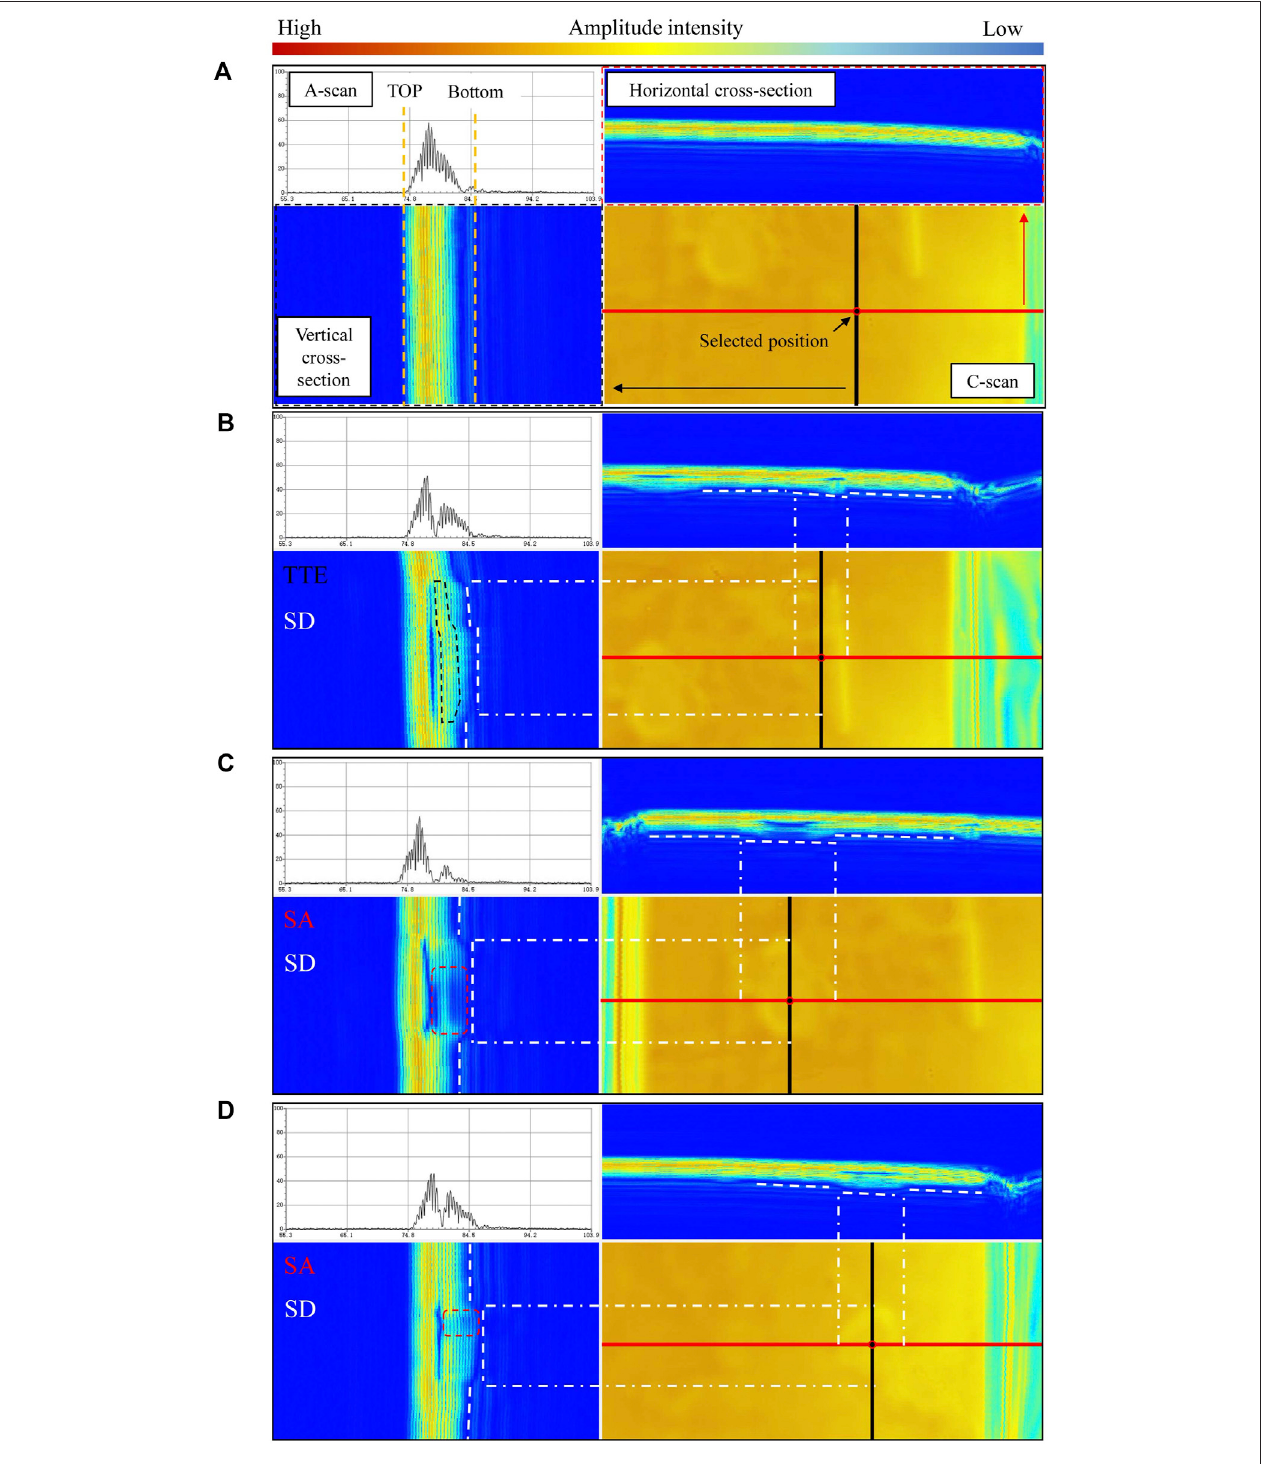
FIGURE 13 | Comprehensive re fl ection images of rear side for defects (images for Cu and Al foils on cathode surface can be found in Supplementary Material ).